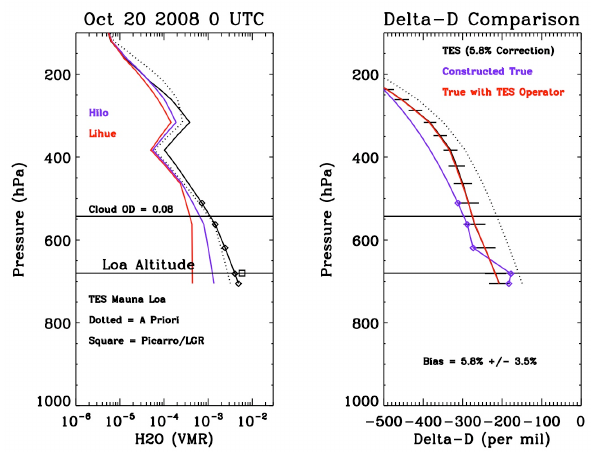
Fig. 4. (Left Panel) TES and sonde H 2 O. The colored solid lines show H 2 O measurements from sondes launched in Hilo and Lihue and modified by the TES H 2 O averaging kernel and a priori con- straint (dotted line). Right Panel: the TES δ -D profile (corrected for bias), the a priori constraint (dotted line), the constructed “true” δ -D profile (solid blue line), and the “true” profile modified by the TES averaging kernel and a priori constraint (solid red line). The error bars are due to measurement and interfering geophysical parameters as well as errors in the constructed “true” profile. The cloud top height is the solid line. Diamonds in both plots refer to the pressure levels used to construct the “true” δ -D profile. The square in the left panel is the corresponding in situ measurement at the time of the TES overpass.